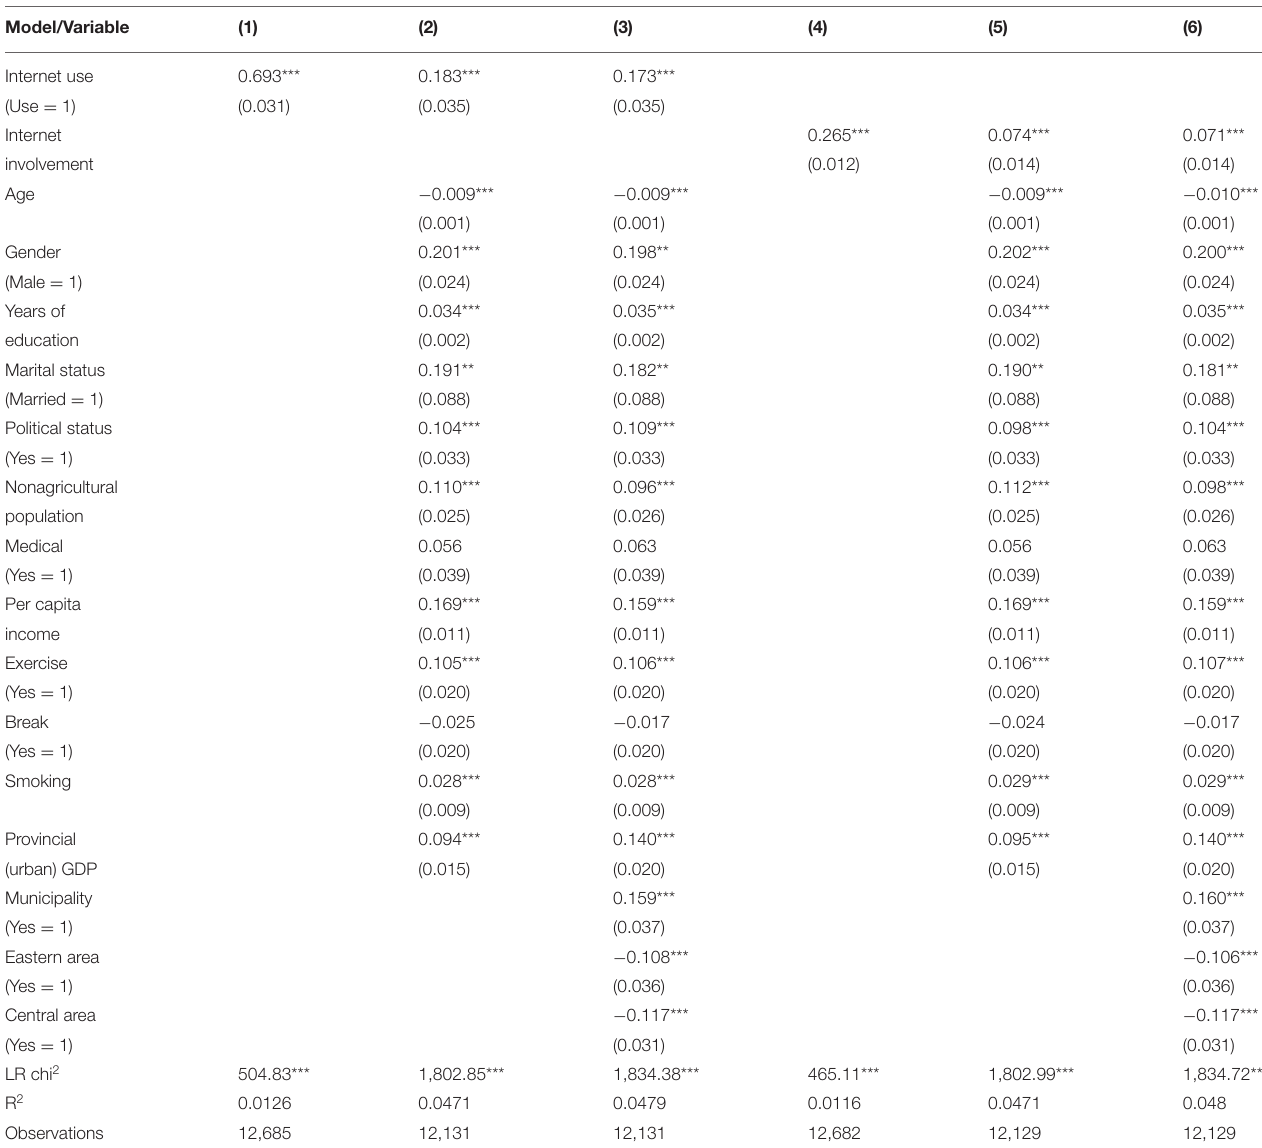
TABLE 2 | Model results for the effect of the internet on the cognitive health of middle-aged and elderly people.